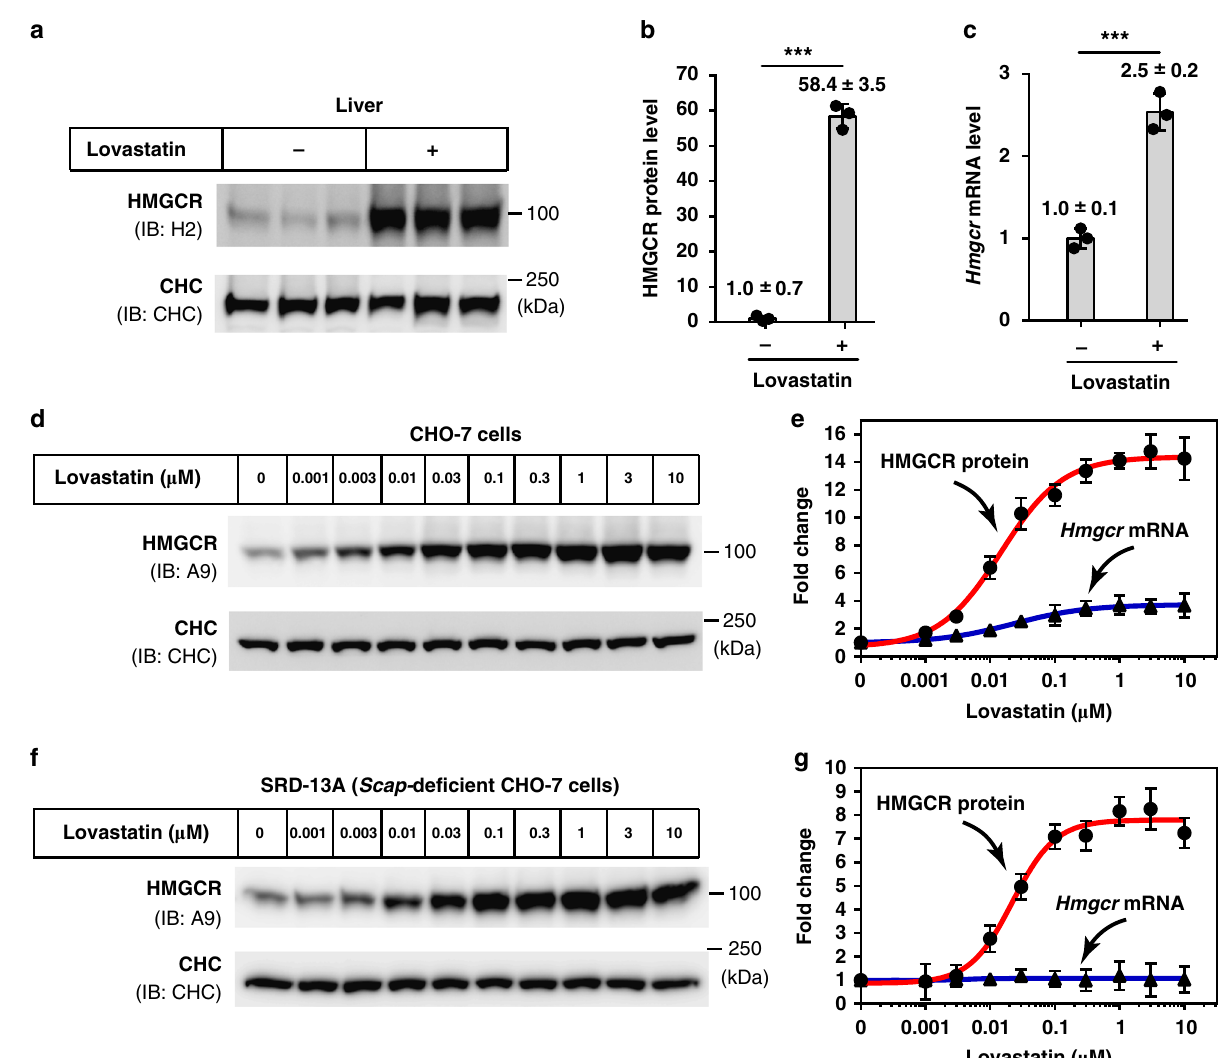
Fig. 1 Lovastatin causes a substantial accumulation of HMGCR protein. a – c Male C57BL/6J mice ( n = 3 per group) were gavaged with vehicle or lovastatin (60 mg/kg/day) once daily for 7 days. Livers were harvested for immunoblotting and RT-qPCR. a Immunoblotting analysis of HMGCR protein from membrane fractions. Clathrin heavy chain (CHC) was a loading control. b Quanti fi cations of HMGCR protein shown in a . The HMGCR protein level of mice gavaged with vehicle was de fi ned as 1. c Quanti fi cations of Hmgcr mRNA level by RT-qPCR. The Hmgcr mRNA level of vehicle-treated mice was de fi ned